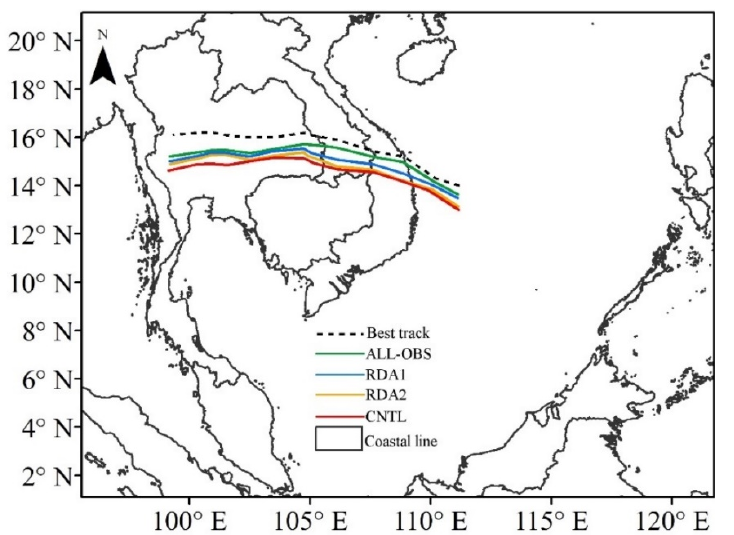
Figure 3. The model’s forecasts tracks with different assimilation experiments (i.e., ALL-OBS, RDA1, RDA2, and CNTL), along with the JMA best track data (black dashed line).